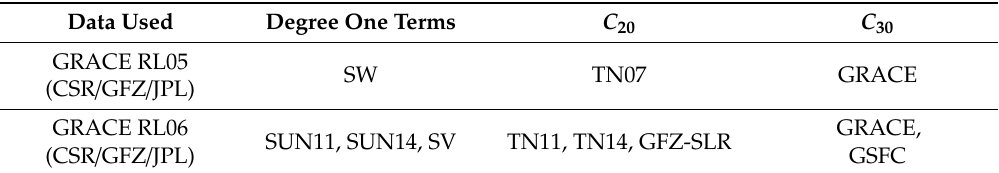
Table 1. The data sets adopted in this study. Only auxiliary data including degree one terms, satellite laser ranging (SLR)-based C 20 and Gravity Recovery and Climate Experiment (GRACE)-determined C 30 estimates separately corresponding to GRACE RL05 and RL06 data (from each data processing center) are analyzed during the GRACE mission span. Besides, SLR-based (GSFC) C 30 estimates